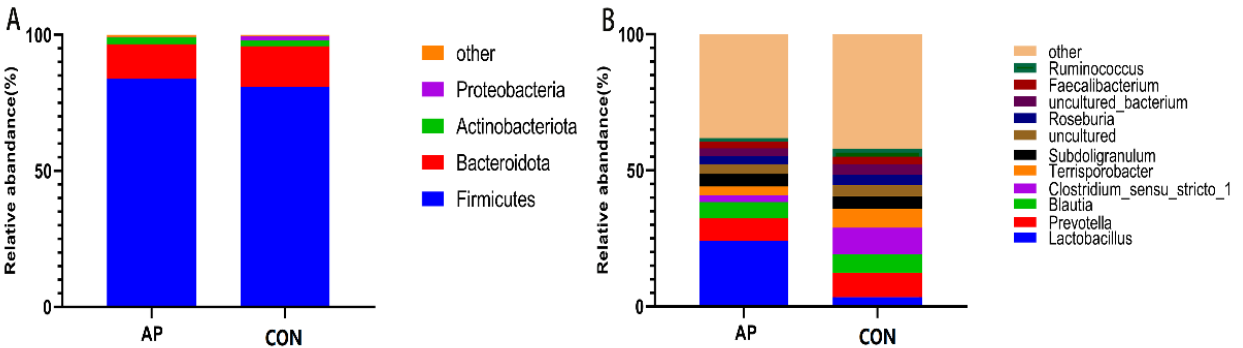
Figure 4. Intestinal bacterial structure (( A ): phylum, ( B ): genus). CON: control group; AP: Apple pomace group.